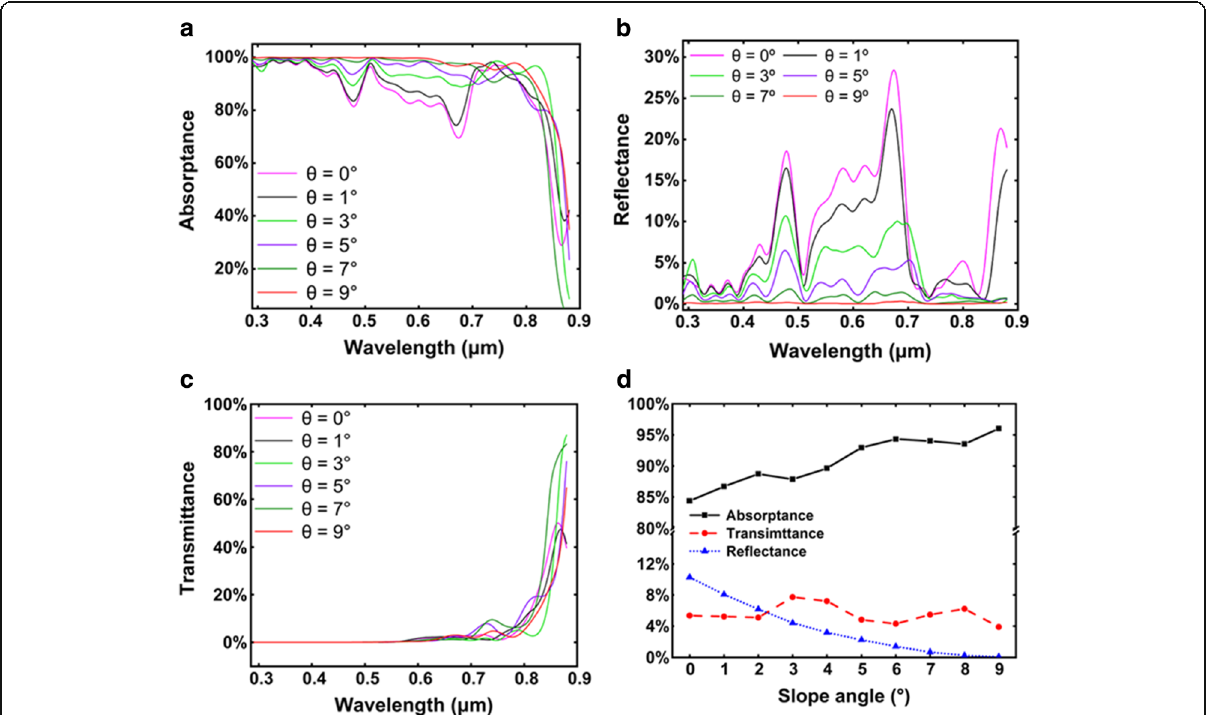
Fig. 7 a Absorptance, b reflectance, and c transmittance of the radial pin junction GaAs nanocone array with D / P = 0.5 and D = 0.36 μ m. d The AM1.5G-weighted integral of the absorptance, reflectance, and transmittance of the radial nanocone array with different slope angles